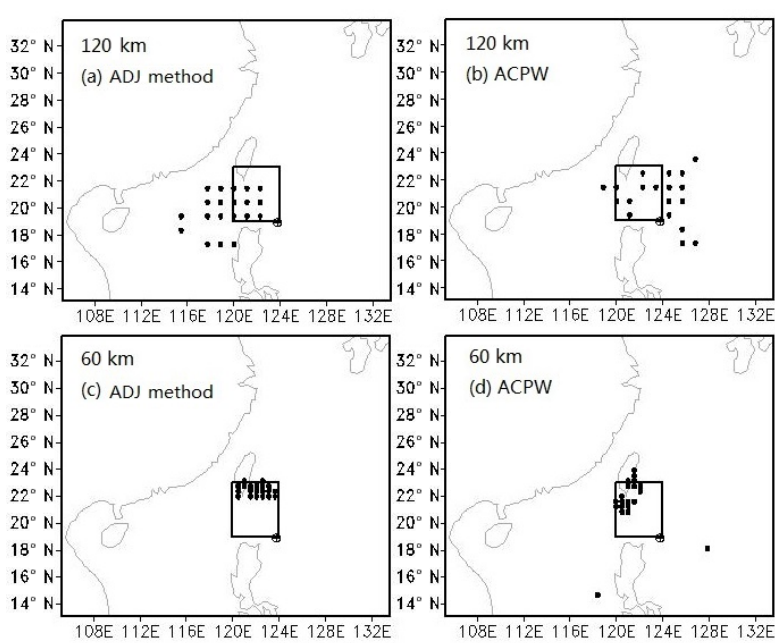
Figure 12. Sensitive regions identified by the CNOPs with 20 points for TC Matmo. The squares indicate the verification areas, and the initial cyclone positions are shown as ⊕ . Letters (a) and (b) denote the CNOP patterns at the 120km resolution for the ADJ method and the ACPW algorithm, respectively, while letters (c) and (d) represent the CNOP patterns at the 60km resolution for the ADJ method and the ACPW algorithm, respectively.